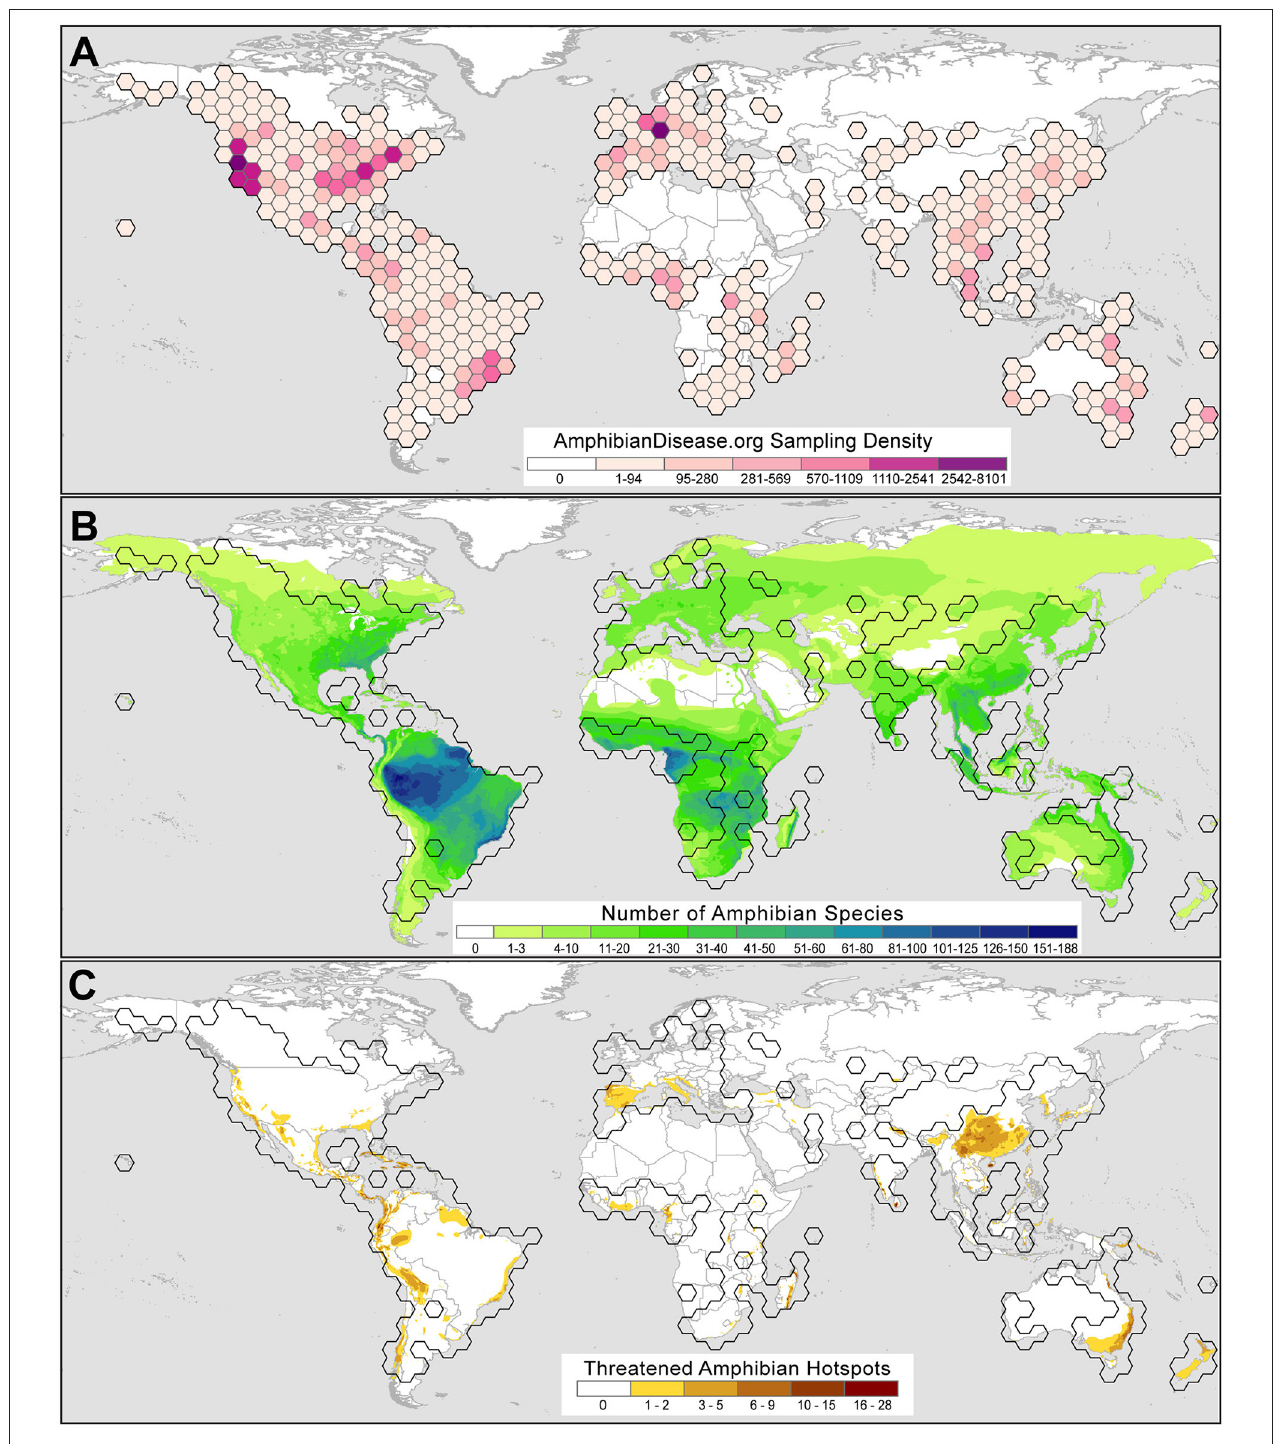
FIGURE 3 | Amphibian Disease sampling point data for the chytrid fungal pathogens Batrachochytrium dendrobatidis ( Bd ) and B. salamandrivorans ( Bsal ) summarized by 5-degree latitude and longitude bins as of June 2021. (A) Bd and Bsal sampling is worldwide and reflects prominent sampling efforts for Bsal in the USA by the US Geological Survey (39) and in Germany by the Bsal Consortium Germany (42). Sampling strength is classified using natural breaks with Jenks optimization where darker colors denote greater numbers of samples per bin. (B) Bd and Bsal global sampling with respect to amphibian species alpha-diversity, where darker gradient denotes greater number of amphibian species. (C) Bd and Bsal global sampling with respect to threatened amphibian species, where darker gradient denotes greater number of threatened amphibian species. Range map sources: AmphibiaWeb (2021; https://amphibiaweb.org) and IUCN Red List (2021; https://www.iucnredlist.org). Threatened species status: IUCN Red List (IUCN 2021, accessed June 10, 2021).